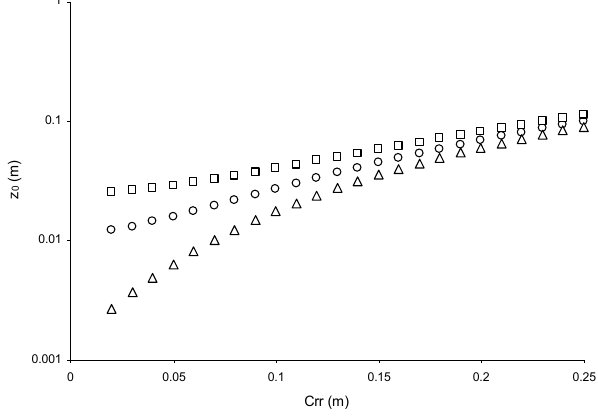
Fig. 5. Aerodynamic roughness length ( z 0 ) as a function of the ran- dom roughness ( C rr ), from Eq. (3). Circles, squares and triangles correspond to RH 2 /RS =0.09, 0.025 and 0.001m, respectively.